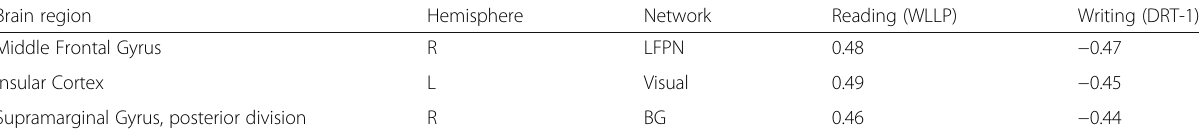
Table 6 Regions with changed functional connectivity in functional illiterates after training ( n = 20) compared to before training in which we found significant correlation ( p < 0.005, two tailed) to WLLP and DRT1. The table shows the Pearson coefficient